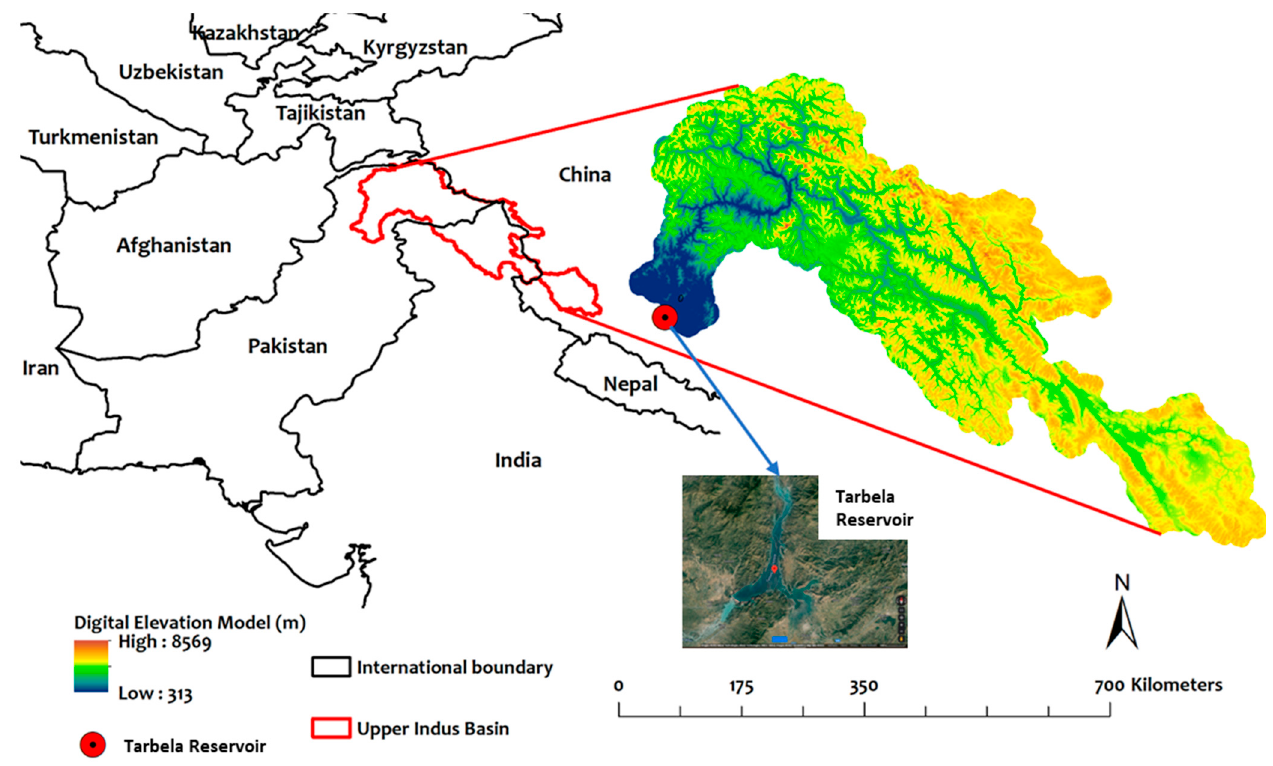
Figure 1. Tarbela reservoir catchment.